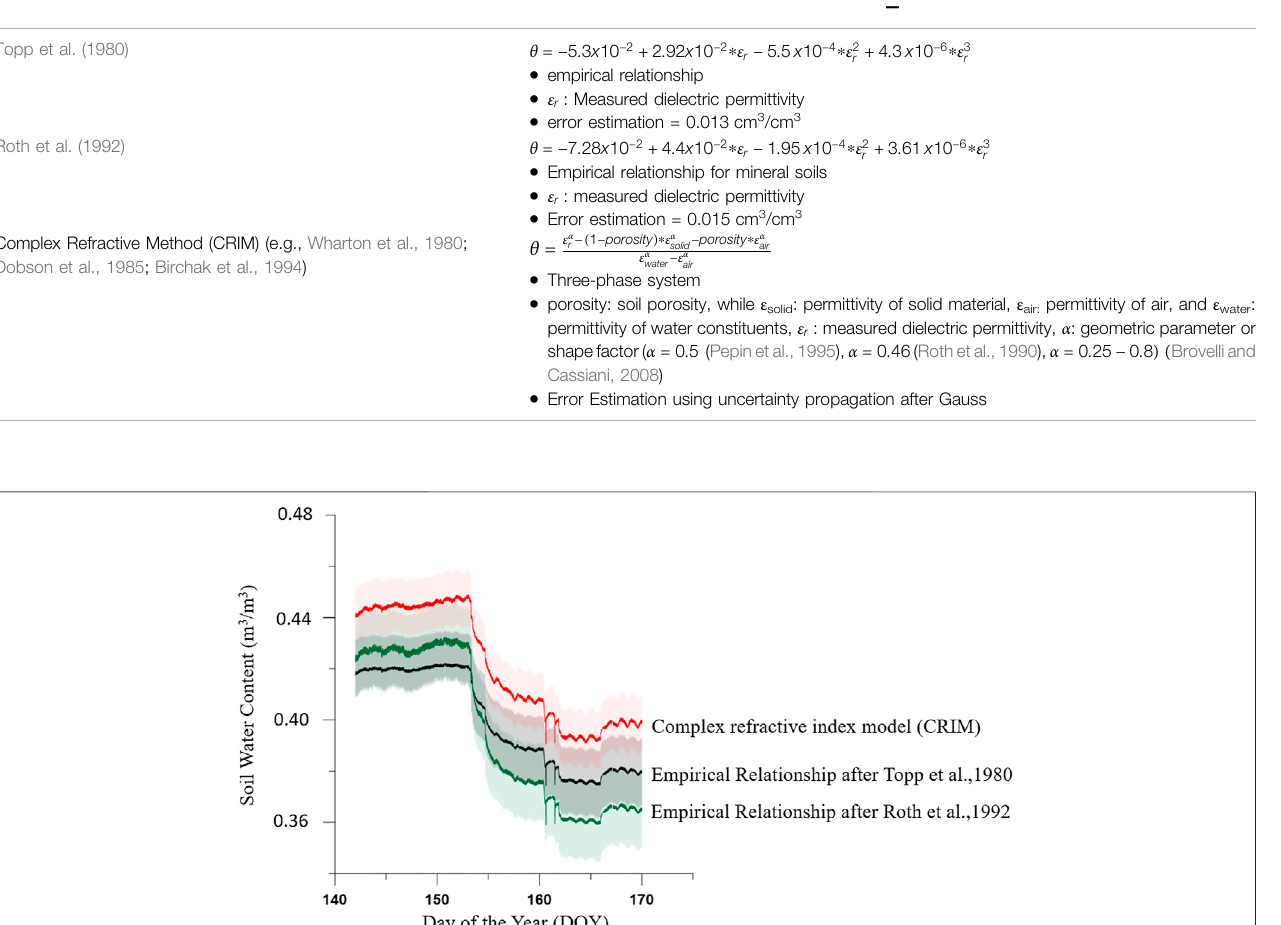
TABLE1| DiscussedPedo-TransferFunctions(PTFs),theirrelationshipofrelativepermittivityordielectricconstanttovolumetricwatercontentinsoil(soilwatercontent)and error estimation. Topp et al. (1980)